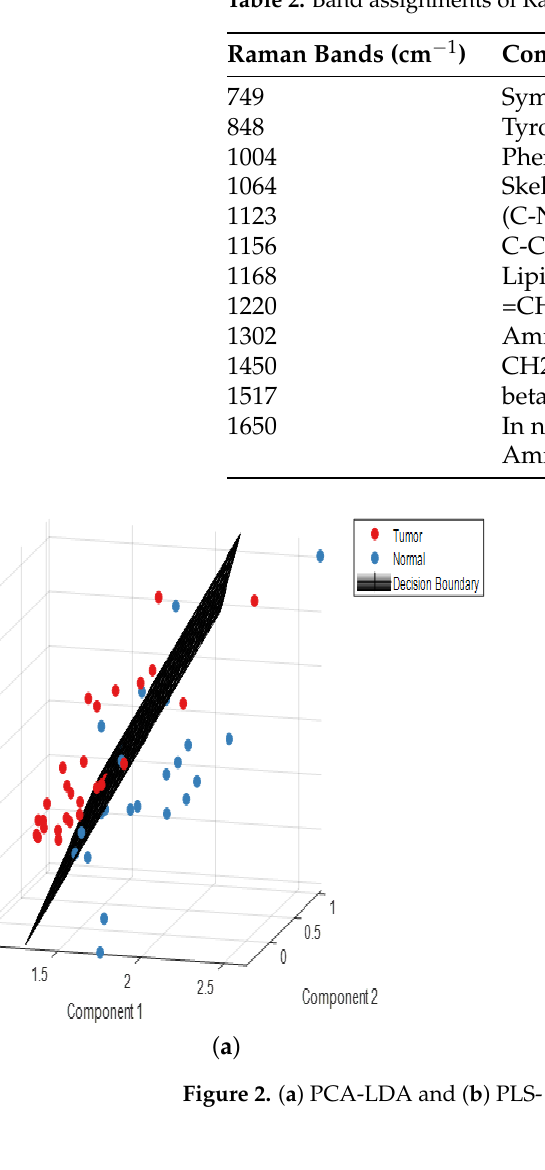
Table 2. Band assignments of Raman peaks [12,17,19,28].